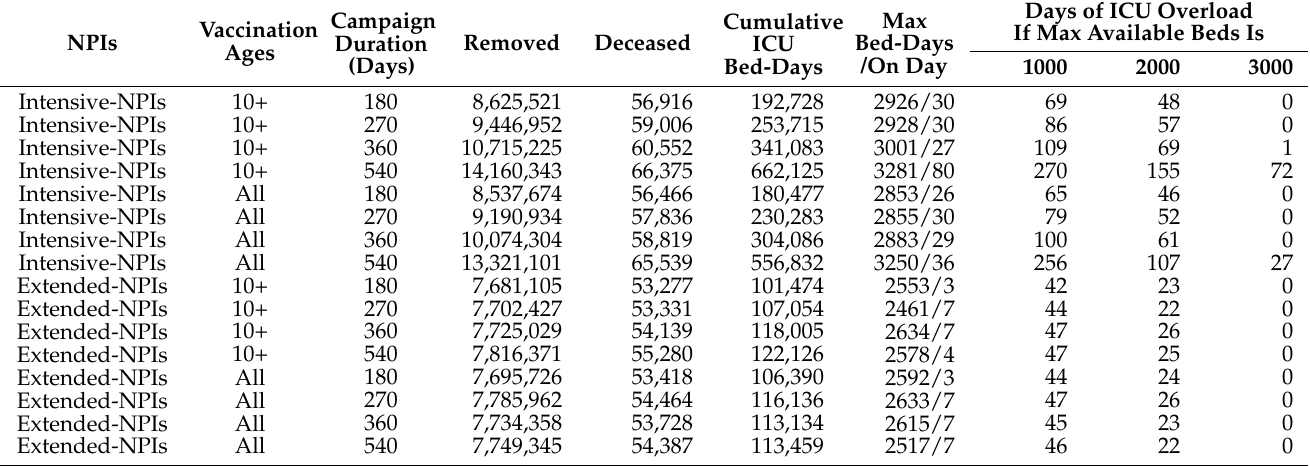
Table 3. Results of a vaccine with 90% transmission reduction, with the historical strain and Alpha variant under different vaccination ages, campaign duration, and non-pharmaceutical interventions (NPIs). Cumulative numbers of individuals removed and deceased on 30 June 2022, cumulative ICU bed-days required, maximum daily ICU bed-days required, and intensive care unit (ICU) overload (exceeding bed–days capacity) over a period of 18